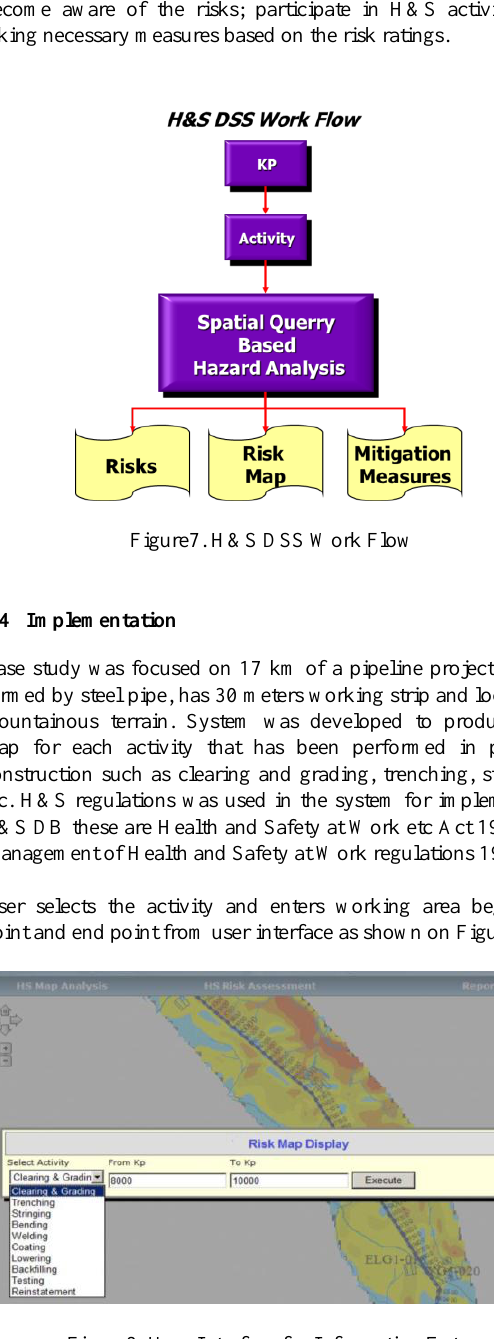
risk score (Figure9.).